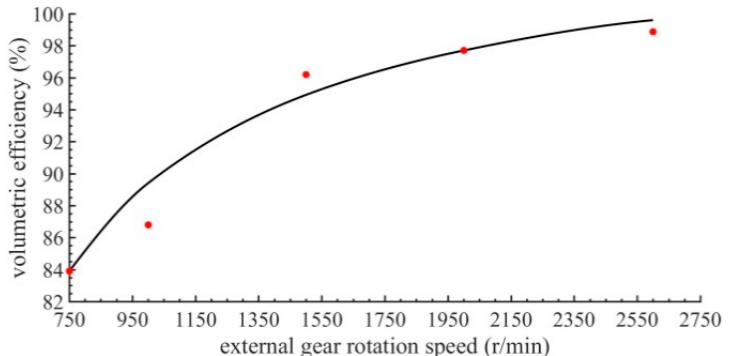
Figure 20. Flow rate-speed characteristic curve.